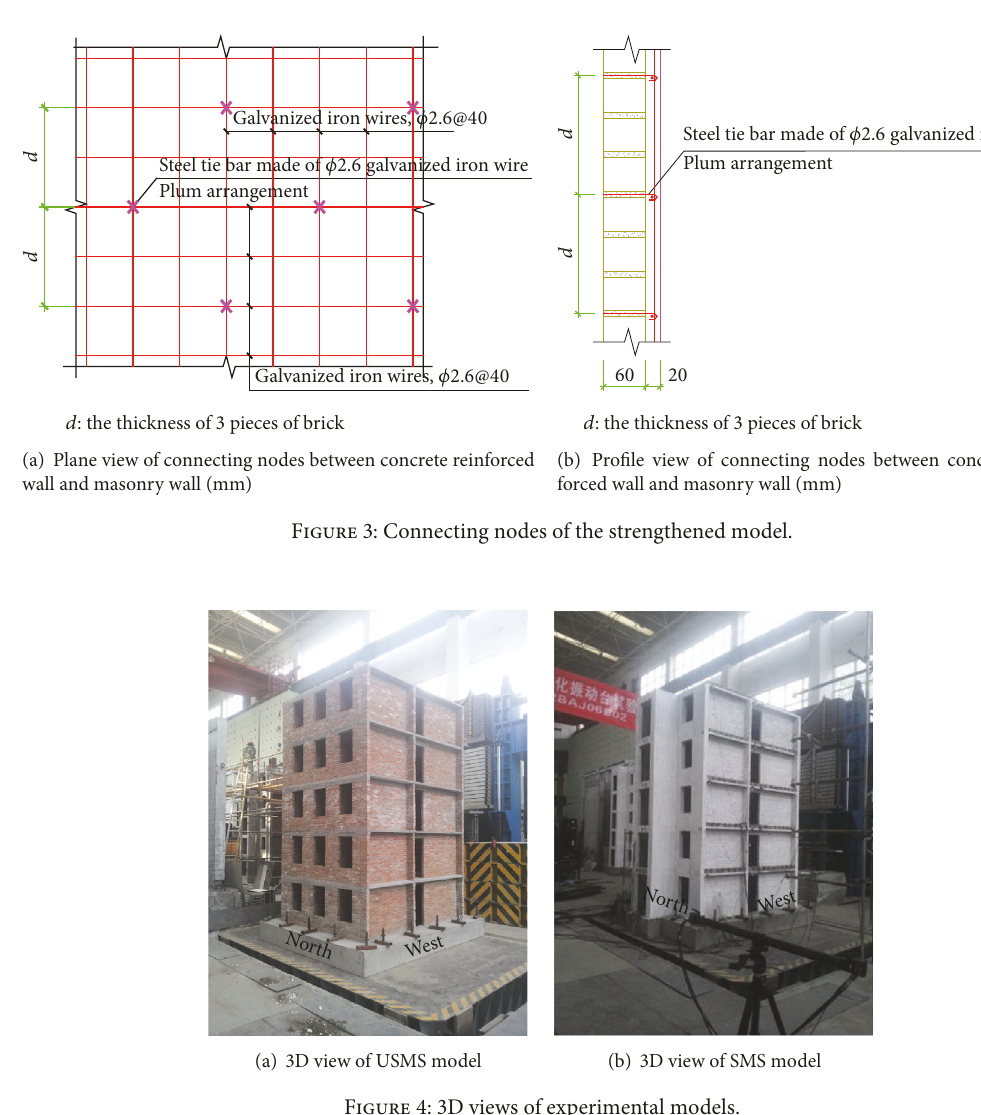
Figure 4: 3D views of experimental